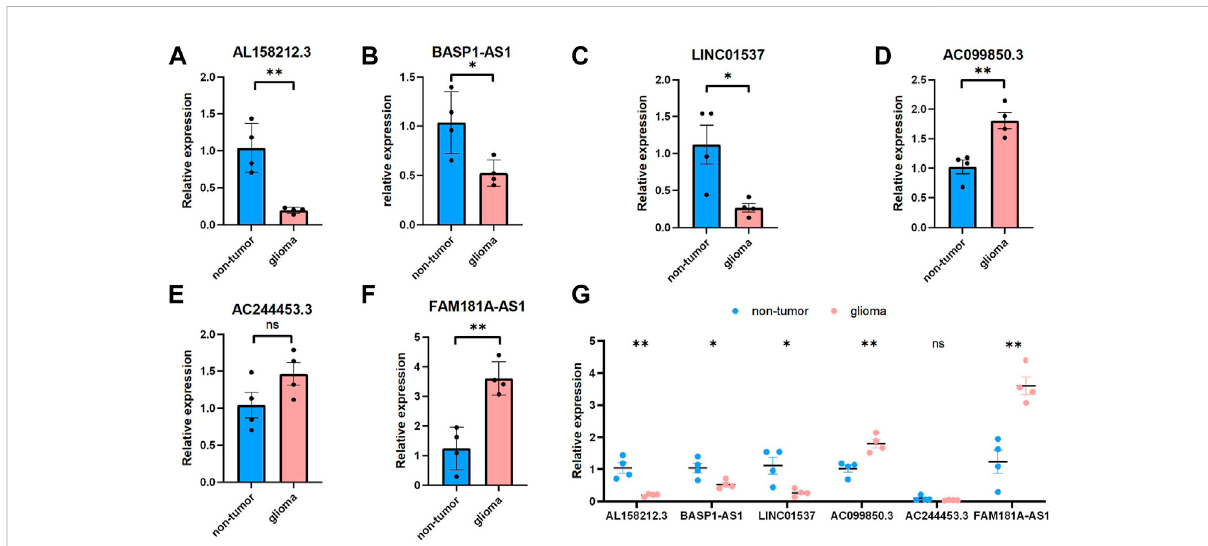
FIGURE 11 Validationsforlongnon-codingRNAsexpressions. (A – C) ExpressionanalysisofthreeprotectivelncRNAs(AL158212.3,BASP1-AS1,LINC01537). (D – F) Expression analysisofthreeriskylncRNAs(AC099850.3,AC244453.3,FAM181A-AS1). (G) ExpressionlevelsofsixCuproptosis-relatedlncRNAs in the non-tumor and glioma by qPCR * p < 0.05, ** p < 0.01, *** p < 0.001, and ns No signi fi